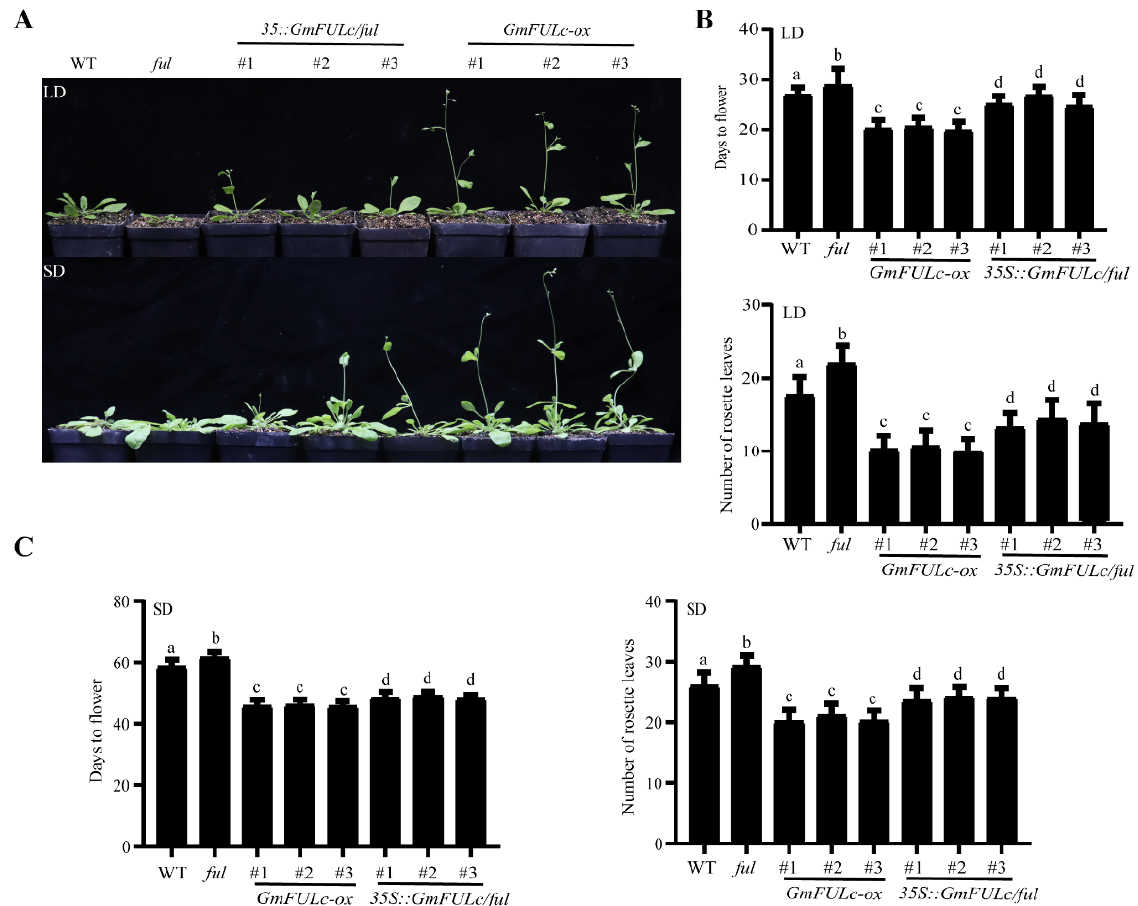
Figure 3. Phenotypes of transgenic Arabidopsis in SDs and LDs. ( A ) Flowering phenotype of GmFULc-ox , ful mutant, 35S:GmFULc / ful restoration and WT plants in SDs and LDs. Photographed after the plants were grown in SDs and LDs for 55 days and 28 days, respectively. ( B ) Days to flower and number of rosette leaves of GmFULc-ox , ful mutant, 35S:GmFULc/ful and WT in LDs. ( C ) Days to flowering and number of rosette leaves of GmFULc-ox , ful mutant, 35S:GmFULc/ful and WT in SDs. Data are shown as means ± SEM. For each experiment, three technical replicates were conducted. One-way ANOVA was used to generate the p values. The same letter denotes nonsignificant differences across the two panels ( p > 0.05).